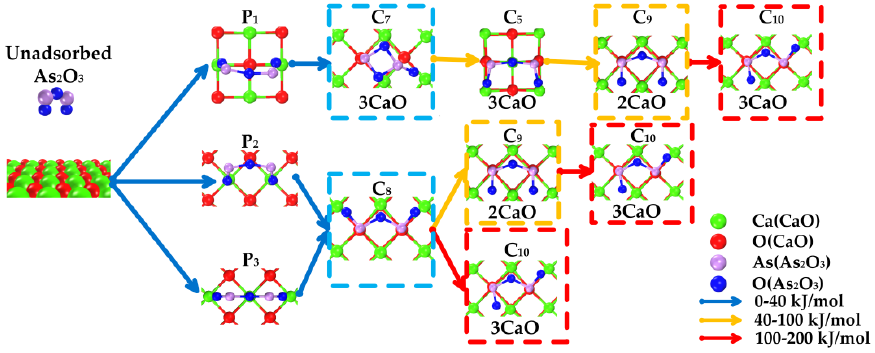
Figure 6. Overall adsorption paths of As 2 O 3 on CaO. Blue arrow: energy barrier is in the range of 0–40 kJ/mol, suggesting that reaction is likely to occur under a relatively low-temperature